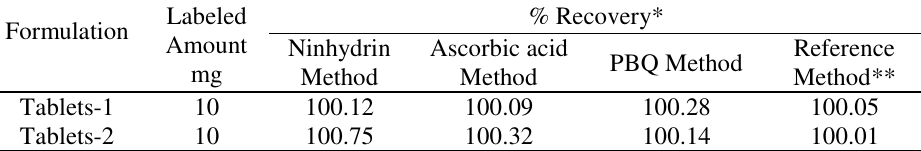
Table 2 . Results of analysis of tablet formulations containing